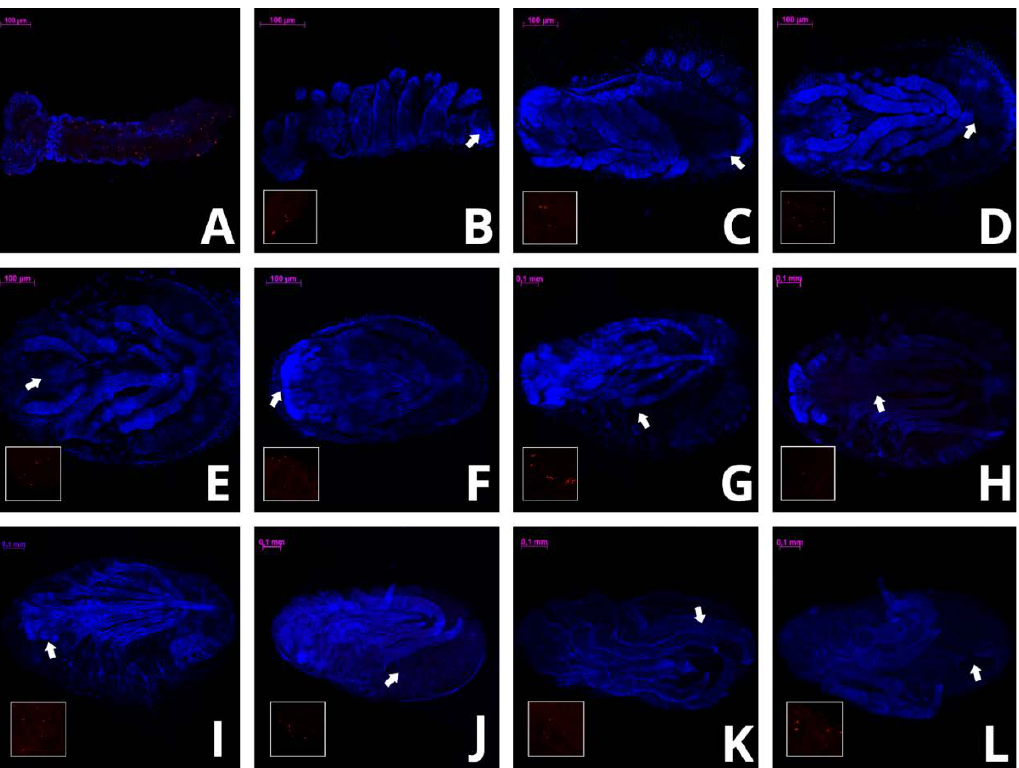
Figure 1. Development of Cinara cupressi embryo; in the gap there are red color cells in mitotic process from the place pointed by the arrow. The pictures show the stages of development on particular days of embryogenesis: ( A ) 16, ( B ) 28, ( C ) 35, ( D ) 49, ( E ) 56, ( F ) 63, ( G ) 70, ( H ) 77, ( I ) 84, ( J ) 91, ( K ) 98, ( L ) 105. All scale bars are 100 µm long. The embryos have a head directed to the left side.